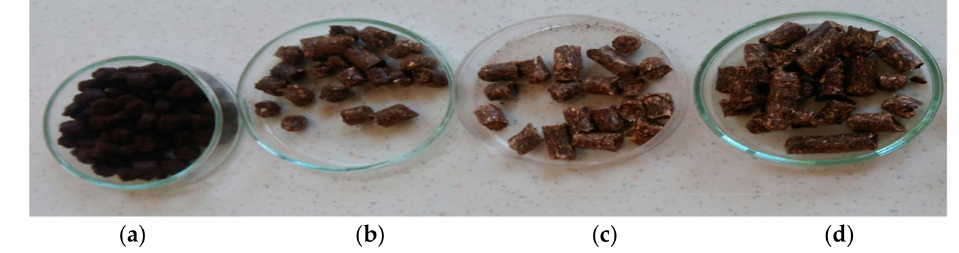
Figure 2. Samples: ( a ) 100% spent co ff ee grounds (SCG), ( b ) 50 / 50 SCG / sawdust, ( c ) 40 / 60 SCG / sawdust and ( d ) 30 / 70 SCG /